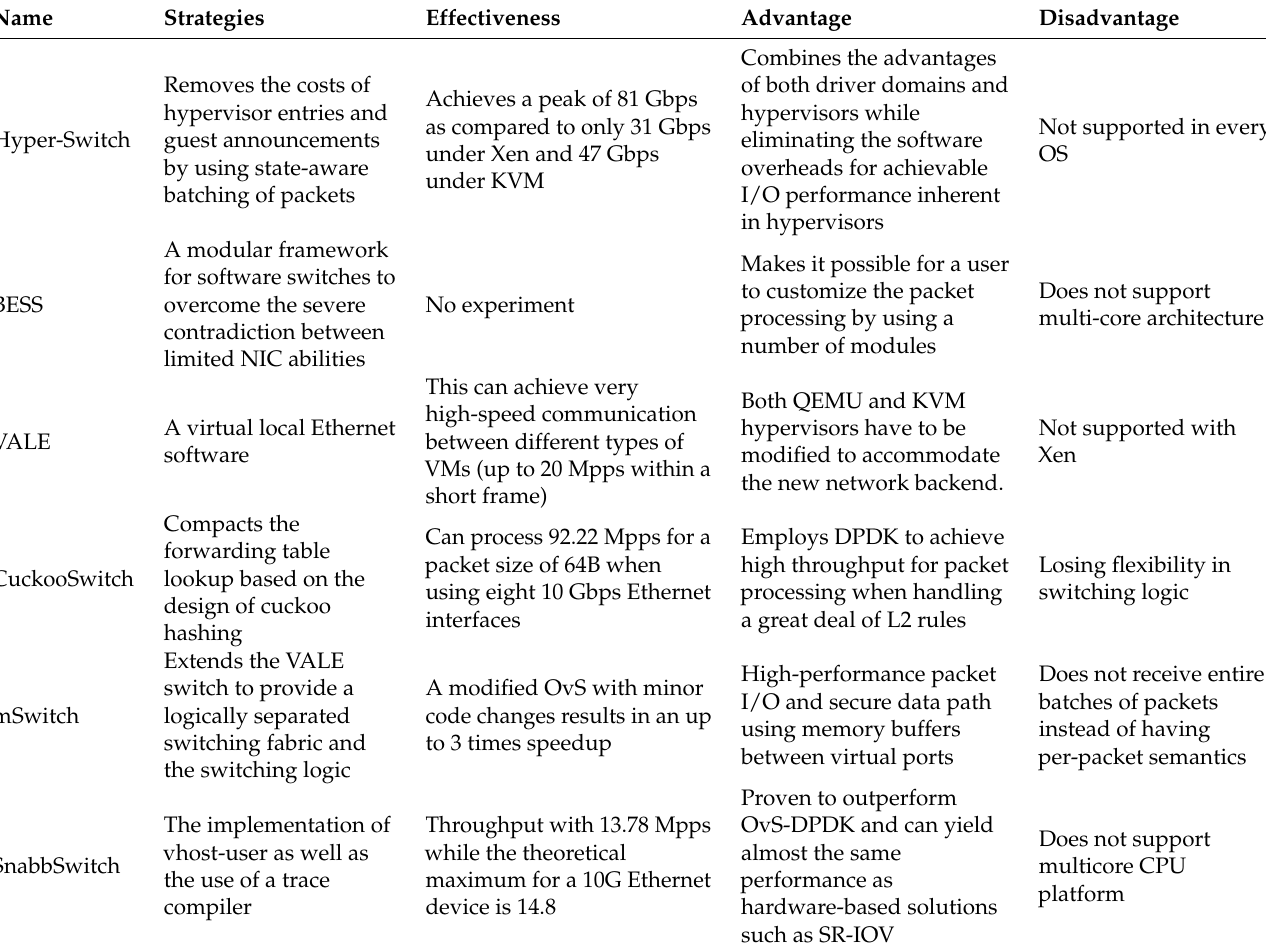
Table 4. The acceleration solutions in